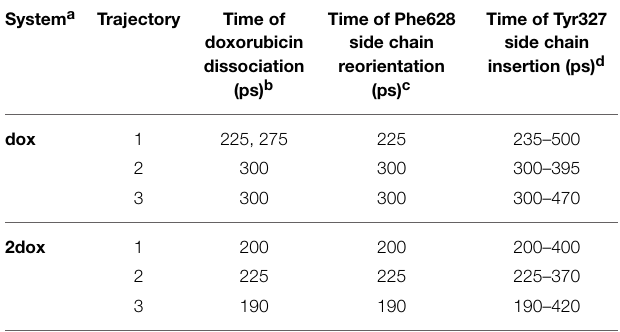
TABLE 1 | Conformational changes associated with the dissociation of doxorubicin. System a